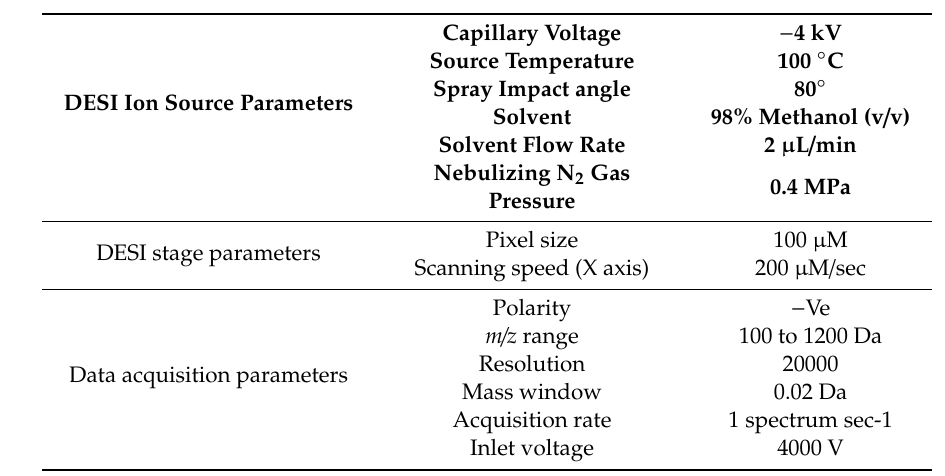
Table 1. Parameters used for DESI-IMS